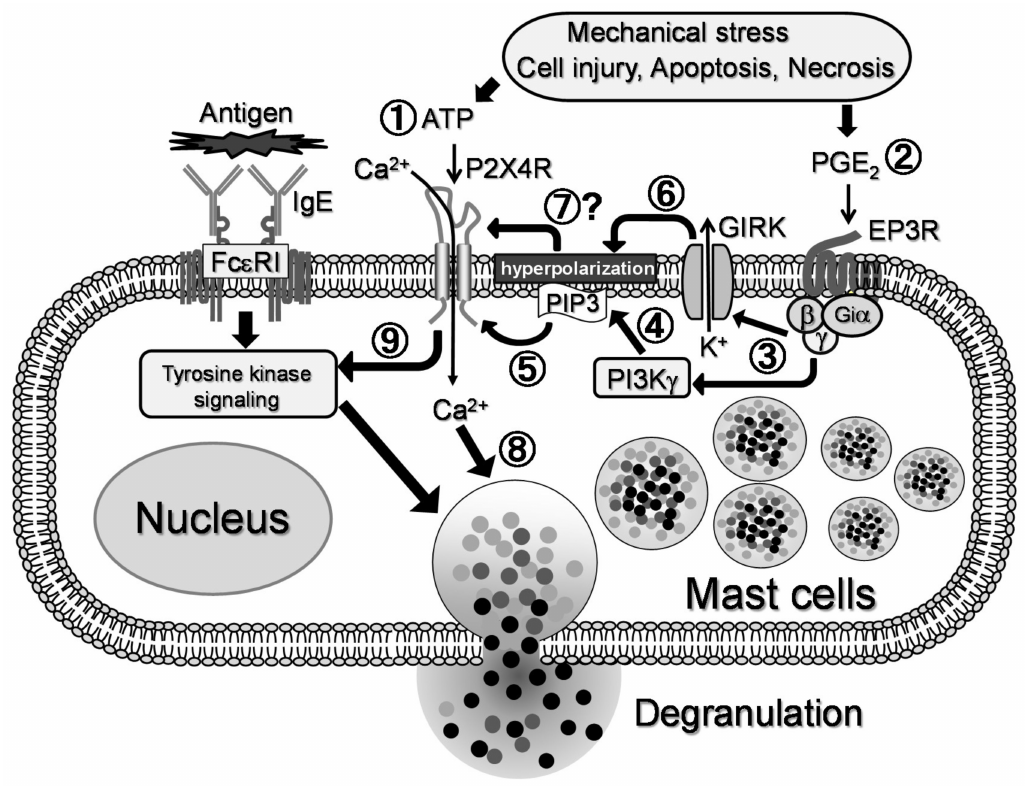
Figure 8. Proposed mechanism of interaction between P2X4 receptor (P2X4R) and EP3 receptor (EP3R) signals for the synergistic degranulation in mast cells(MCs). Extracellular ATP released from damaged cells stimulates MC P2X4R 1 (cid:79) , leading to Ca 2 + influx. Such conditions are accompanied by an inflammation with increased production of prostaglandin (PG)E 2 . In MCs, PGE 2 stimulates Gi-coupled EP3R 2 (cid:79) , leading to activation of phosphoinositide 3-kinase (PI3K) γ and G protein-coupled inwardly-rectifying K + channel (GIRK) via βγ -complex of the G protein 3 (cid:79) . Activation of PI3K γ increases phosphoinositide-3,4,5-trisphosphate (PIP3) levels in plasma membrane 4 (cid:79) , thereby promoting P2X4R channel activity 5 (cid:79) . GIRK activation may cause hyperpolarization of the membrane potential 6 (cid:79) , which would increase the driving force of Ca 2 + inflow through P2X4R 7 (cid:79) . These interactions between P2X4R and EP3R signals lead to the observed synergy in MC degranulation 8 (cid:79) . P2X4R signal also promotes IgE-dependent tyrosine kinase-mediated signals to induce facilitated degranulation, as described previously 9 (cid:79)